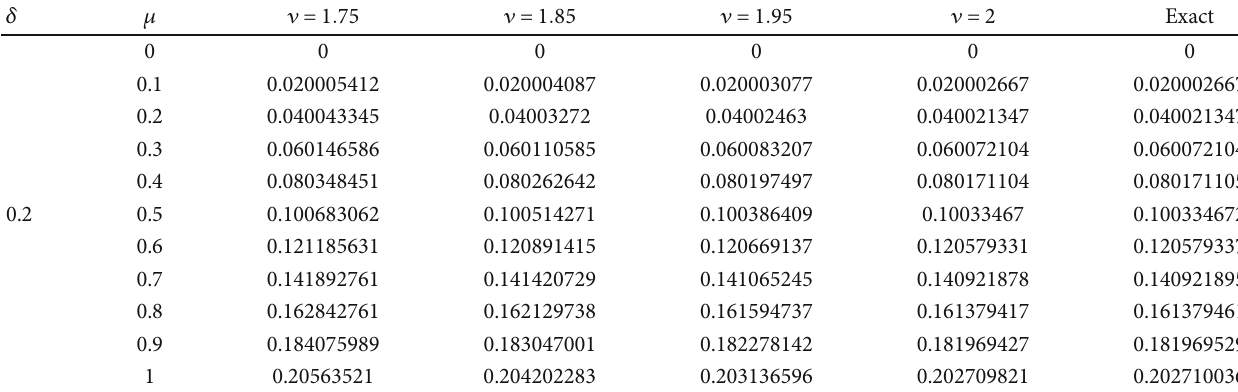
Table 3: Solution for the fi rst three approximations with exact solution, with mesh points δ = 0 : 2 , for equation (34).